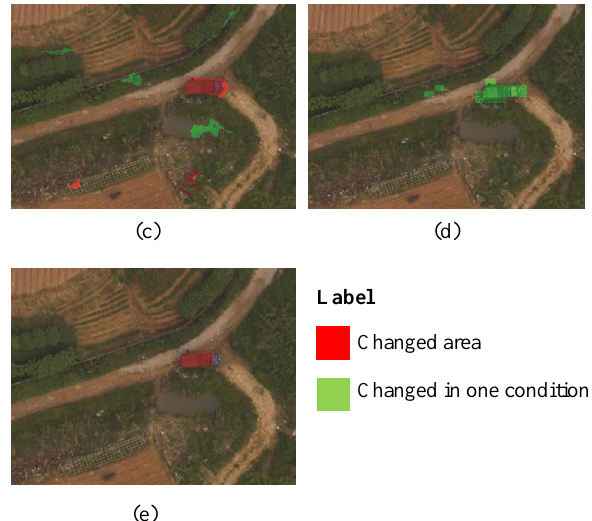
Figure 9. The step of DSM and texture based change detection result from Fixed-wing UAV